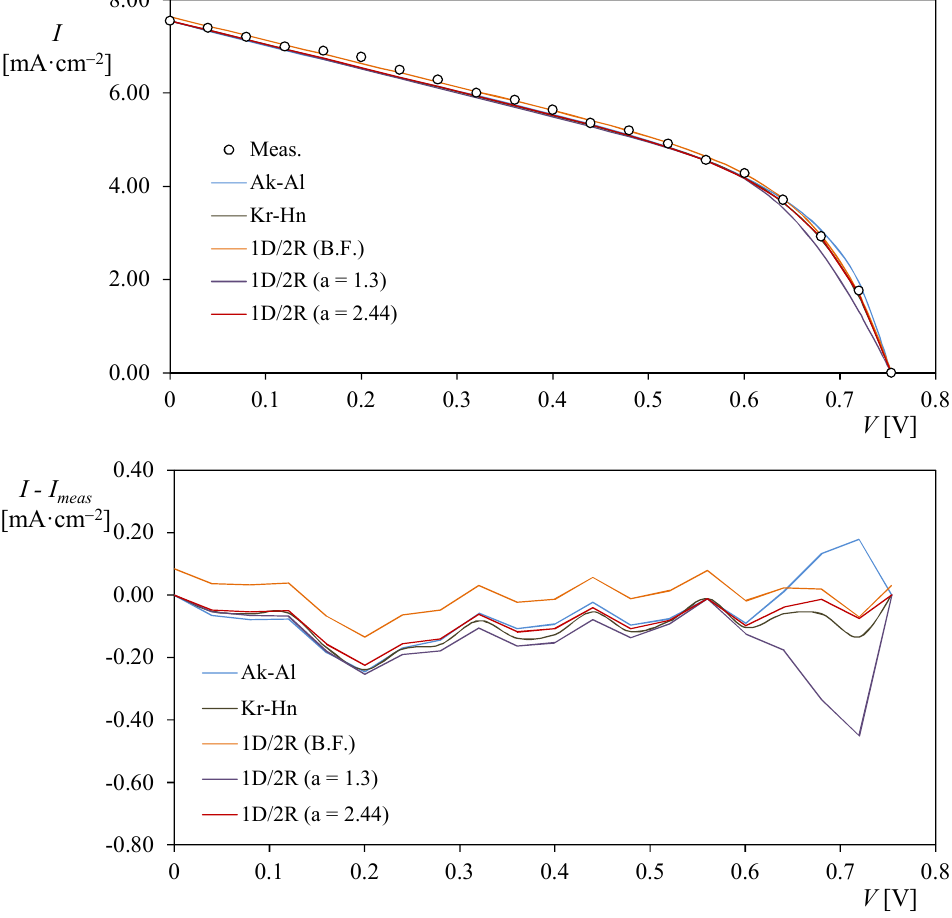
Figure 15. Curves from the Akbaba & Alattawi and Karmalkar & Haneefa explicit models, fitted to plastic solar cell data using the analytical methods proposed (see Section 2), along with three fittings of the 1-diode/2-resistor equivalent circuit model defined by Equation (1) (above). The error in relation to the data is also included in the figure (below).